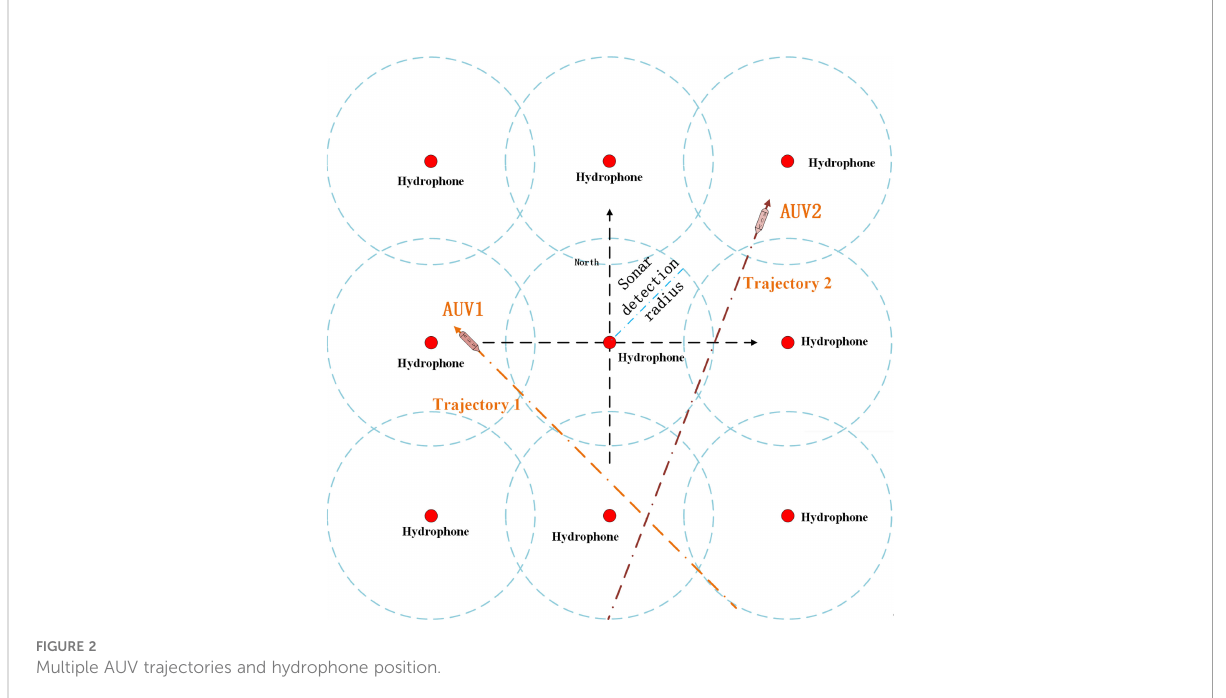
FIGURE 2 Multiple AUV trajectories and hydrophone